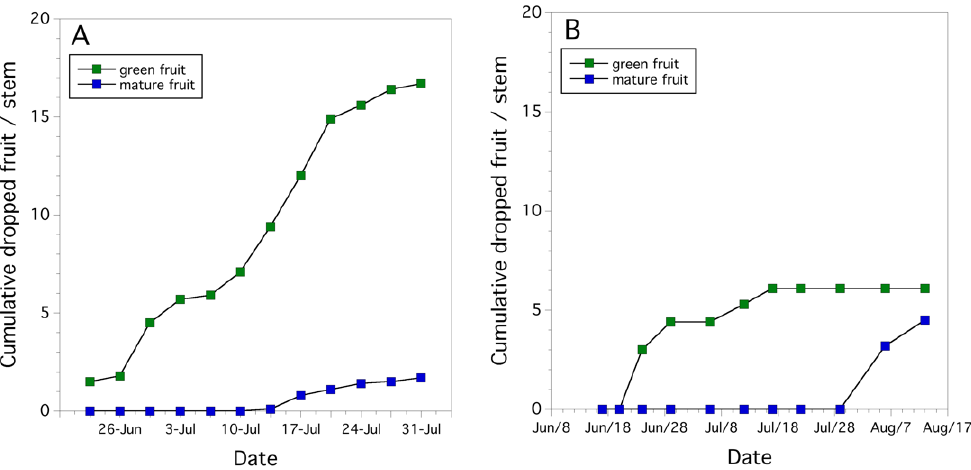
Figure 4. Temporal pattern of wild blueberry fruit drop (green fruit and mature ripe fruit) during the growing season (post-bloom) in eastern Maine, USA: ( A ) 2008; and ( B ) 2011.